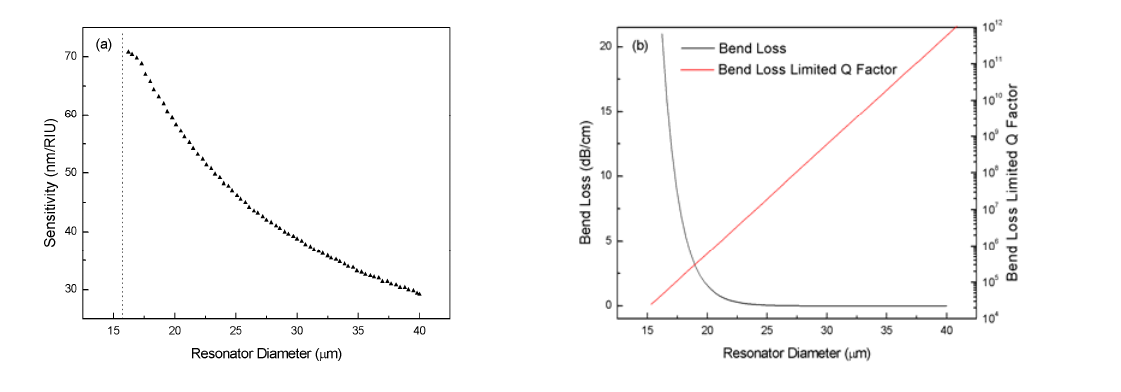
and n , fixed parameters n 2 3